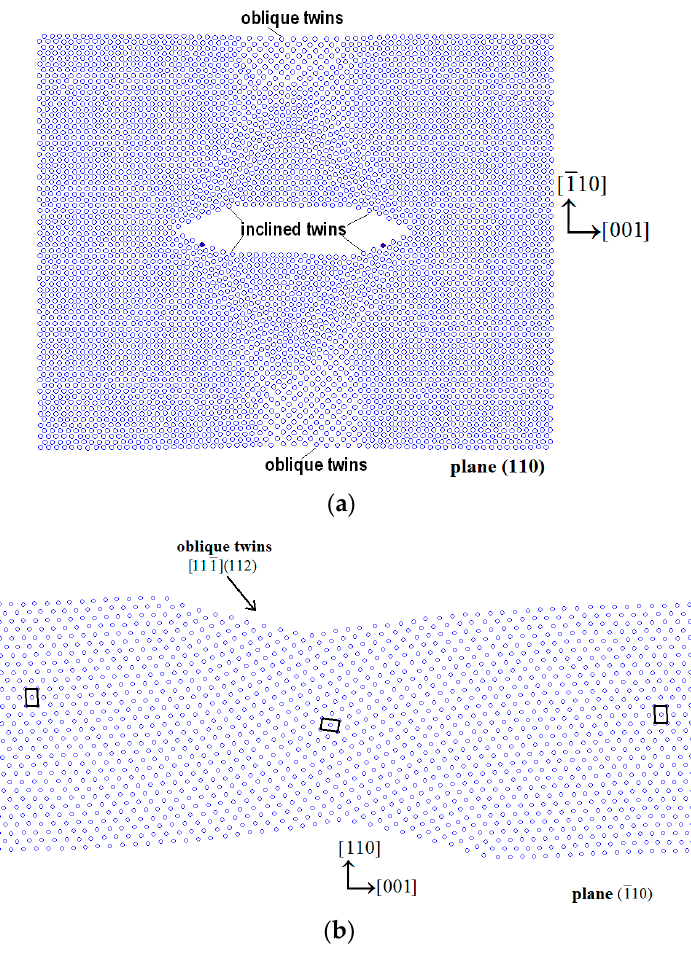
Figure 6. Temperature 300 K, biaxiality ratio α = 1.0: ( a ) slip patterns from the inclined and oblique twins and the crack extension in our (110) observation plane in layer 15. The primary crack tip atoms are dark; ( b ) oblique twins in ( 110 ) plane parallel to the crack plane; (time step 8000, K A ( t ) = 0.803 MPa · m 1 / 2 ).